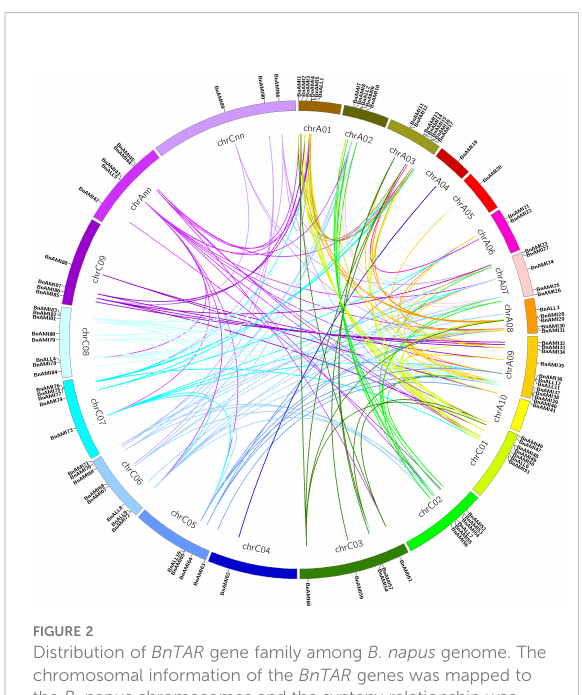
FIGURE 2 Distribution of BnTAR gene family among B. napus genome. The chromosomal information of the BnTAR genes was mapped to the B. napus chromosomes and the synteny relationship was highlighted in different